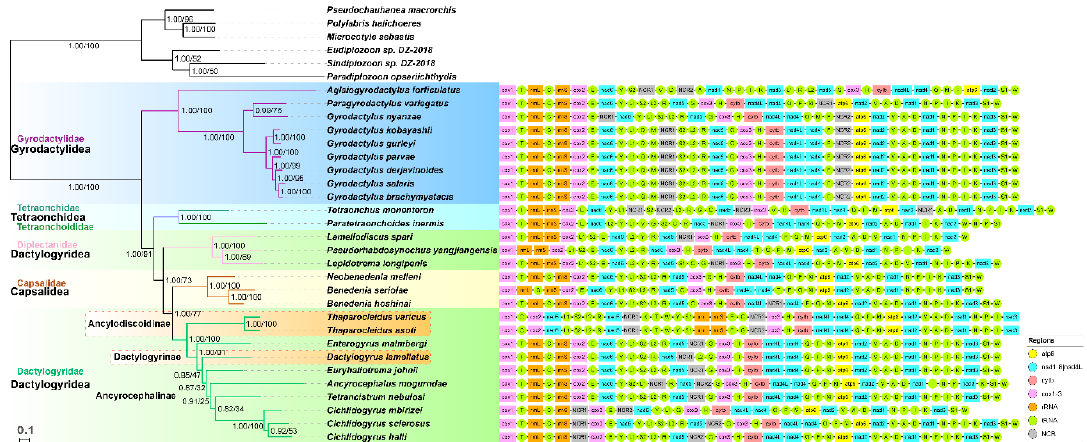
Figure 3. A phylogram reconstructed using mitogenomes of 33 monogeneans and the mtZOA model. Scale bar corresponds to the estimated number of substitutions per site. Statistical support values of Bayesian analyses and maximum likelihood are shown by the nodes (left/right, respectively). Taxonomic families and orders are shown in different colors. Gene orders and non-coding regions (grey boxes) are shown to the right of the tree.